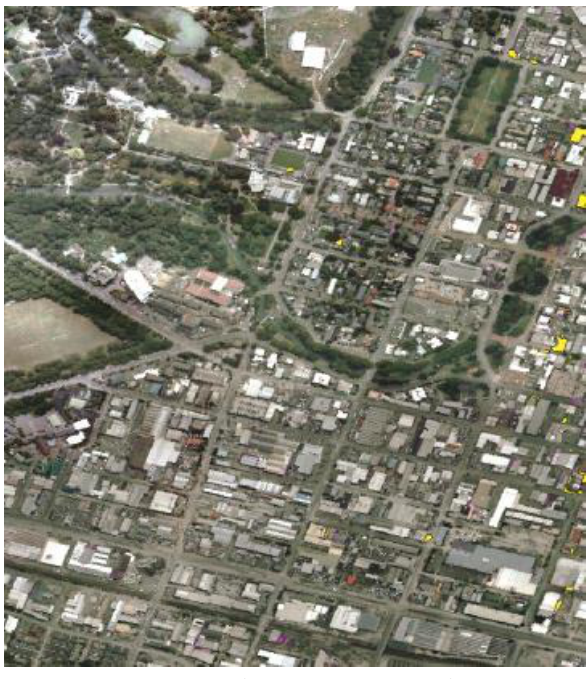
Figure 9. Subimage of the EO image of Christchurch corresponding to the SAR image in Figure 8. The EO image was provided by Land Information New Zealand.